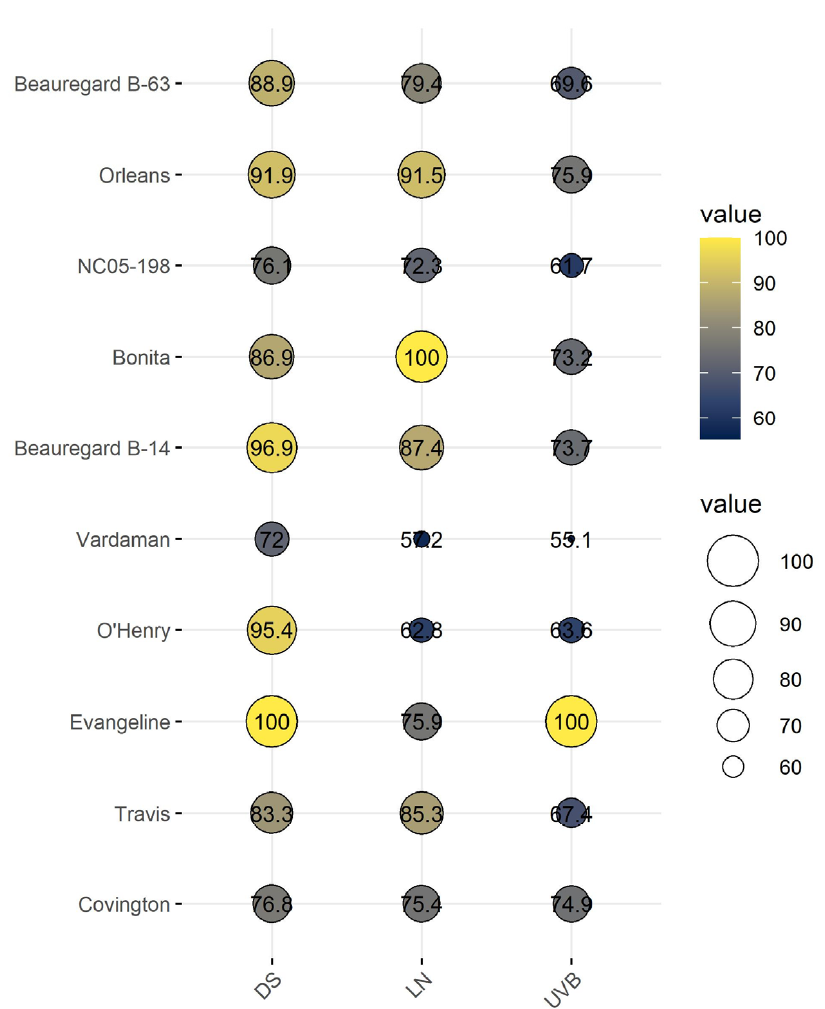
Figure 8. Bubble plot of the cultivars’ total stress indices, calculated from shoot, root, physiological, and gas-exchange traits, of 10 sweetpotato cultivars measured at 20 days after planting under drought (DS), ultraviolet-B (UV-B), and low-nitrogen (LN) stress conditions.